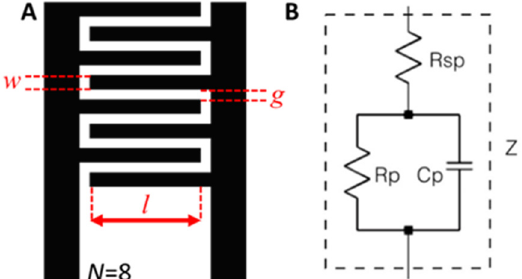
Figure 1. Design parameters of the IDEA: ( A ) geometrical design variables for the IDEAs, and ( B ) equivalent circuit of the IDEA using a three-component circuit.